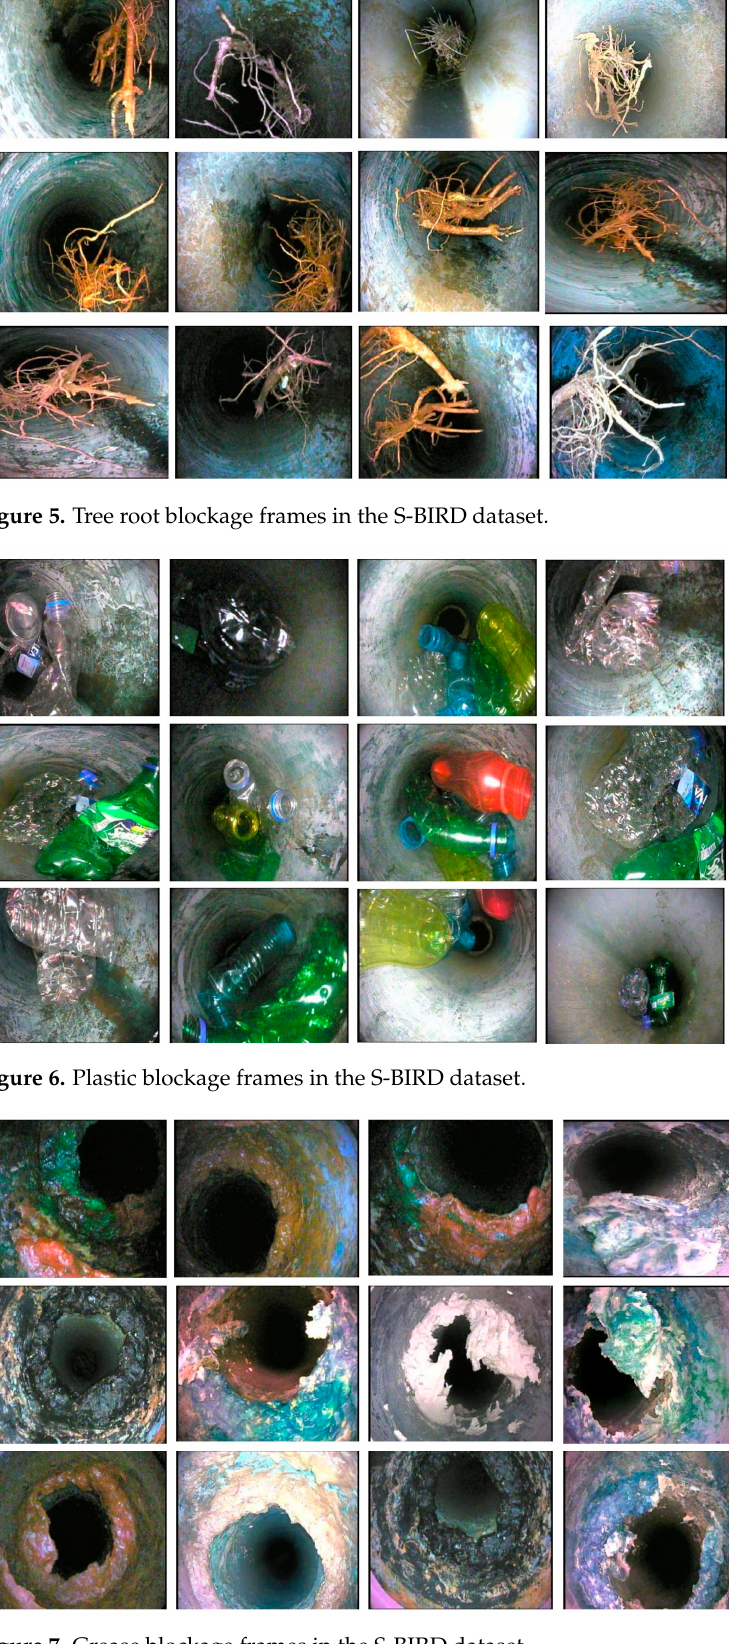
Figure 7. Grease blockage frames in the S-BIRD dataset.